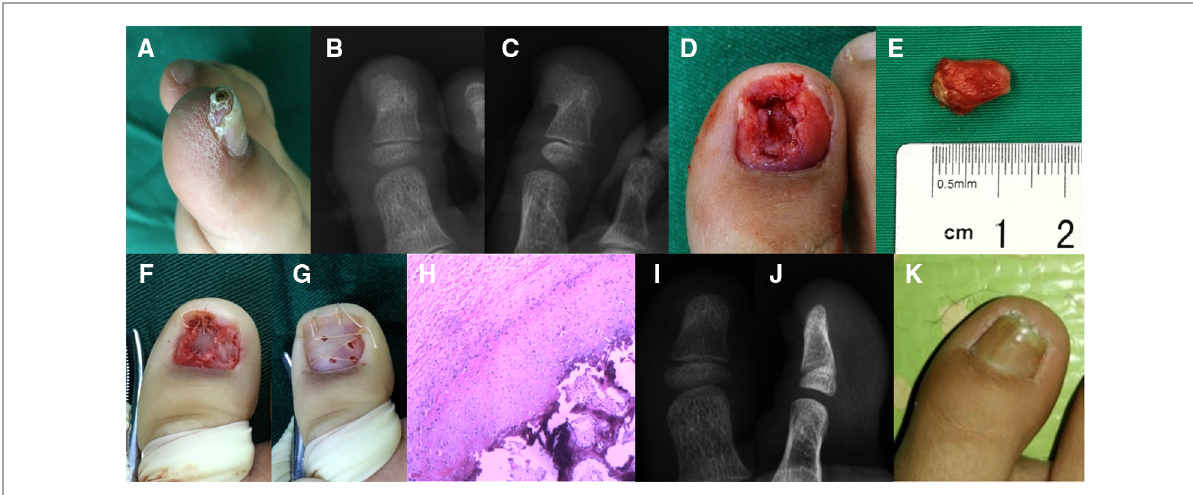
FIGURE 1 Subungual exostosis of the great toe in a 7-year-old boy. ( A ) Physical examination revealed a hard protuberant lesion measuring 1.2×0.8 cm under the right great toe. ( B,C ) Radiographically, there was a calci fi ed projection on the dorsomedial side of the distal phalanx, which was continuous with the normal underlying bone. ( D,E ) The nail bed was invaded by the lesion and the exostectomy was performed. ( F ) The damaged nail bed was repaired by cutting a thin layer of tissue from the normal nail bed. ( G ) Replantation of the toenail was adopted. ( H ) Histopathological analysis (hematoxylin-eosin staining, ×40 magni fi cation) revealed normal trabecular bone and fi brocartilage were overgrown, these fi ndings were consistent with the diagnosis of subungual exostosis. ( I – K ) No recurrence was found on posteroanterior and lateral radiographs, and the appearance of the toenail remained good during 12 months of follow-up. The patient ’ s parents provided written informed consent to publish the details of the patient ’ s case.